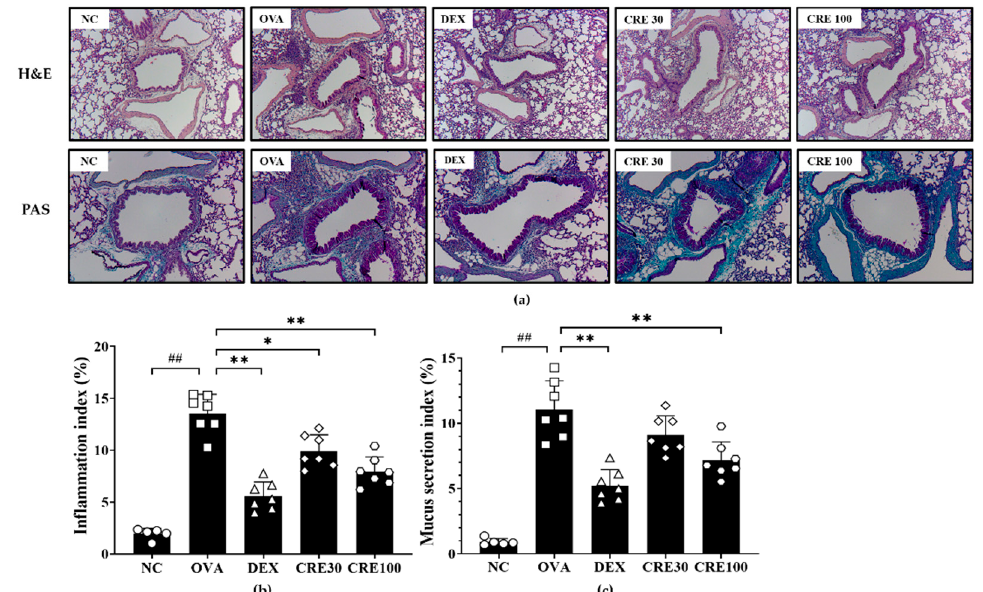
Figure 4. CRE attenuated airway inflammation and mucus secretion of lung tissue from animals with asthma. ( a ) Airway inflammation (H&E stain) and mucus secretion (PAS stain), ( b ) inflamma-